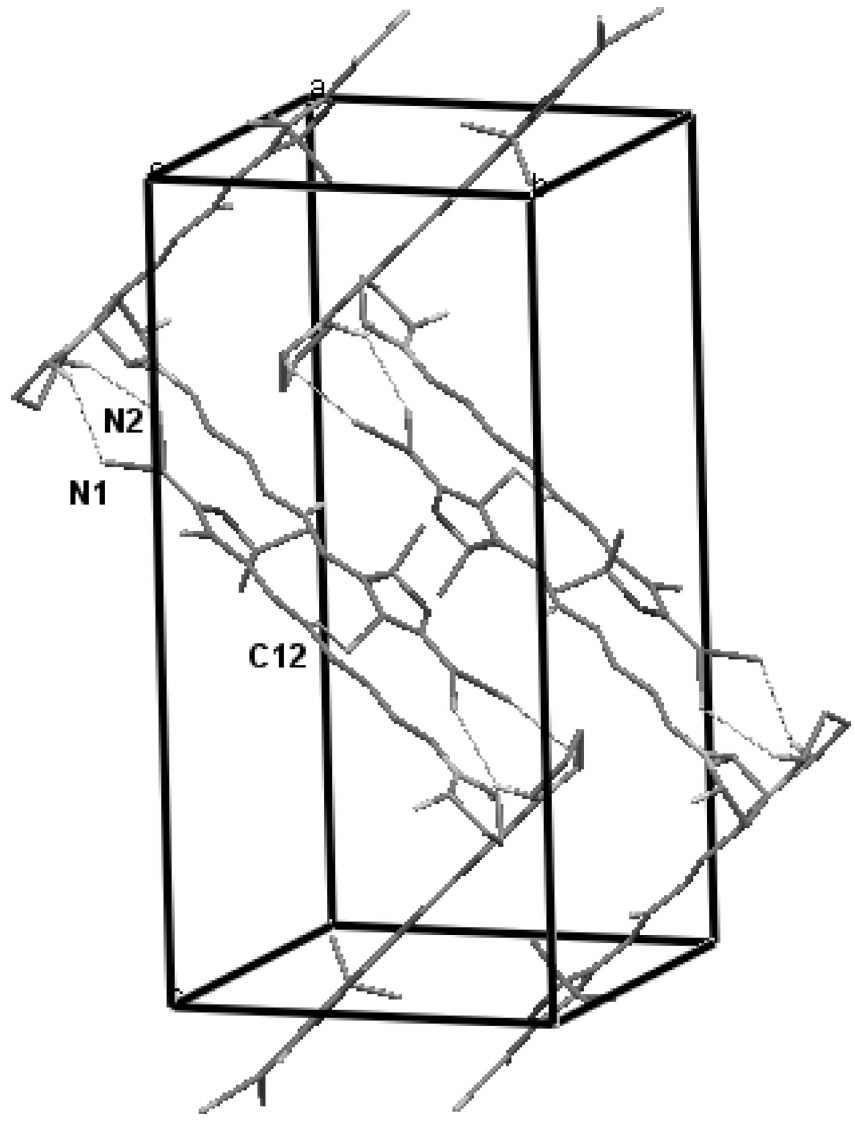
Figure 2 Partial packing diagram of the cell (I) (Mercury; Macrae et al. , 2006) viewed approximately down the a axis. Only H atoms involved in selected C—H···N hydrogen bonds (dashed lines) are shown. Atom labels indicate the three main interactions (see text & Table 1). Colours: Nitrogen, blue; Oxygen, red; Carbon,